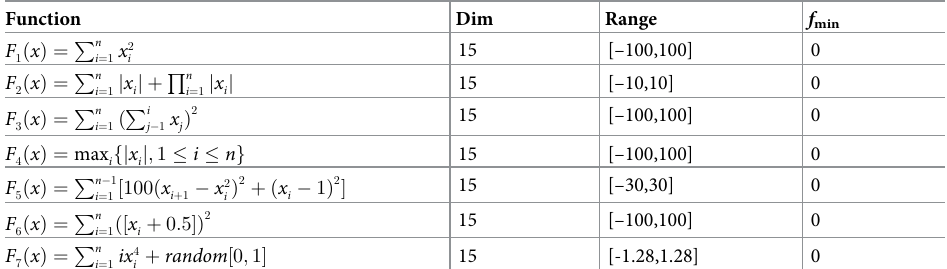
Table 1. Unimodal benchmark functions. Function